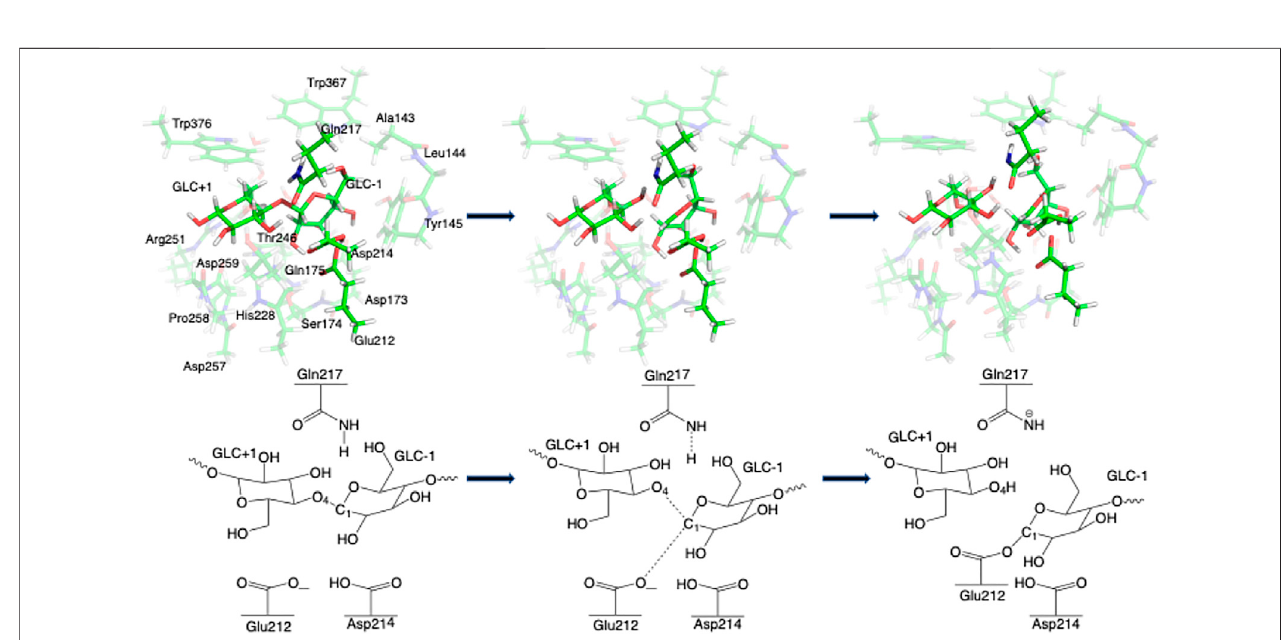
FIGURE 4 | 3D and 2D representation of glycosylation reaction mechanism of the Res23-Q model of 4C4C.